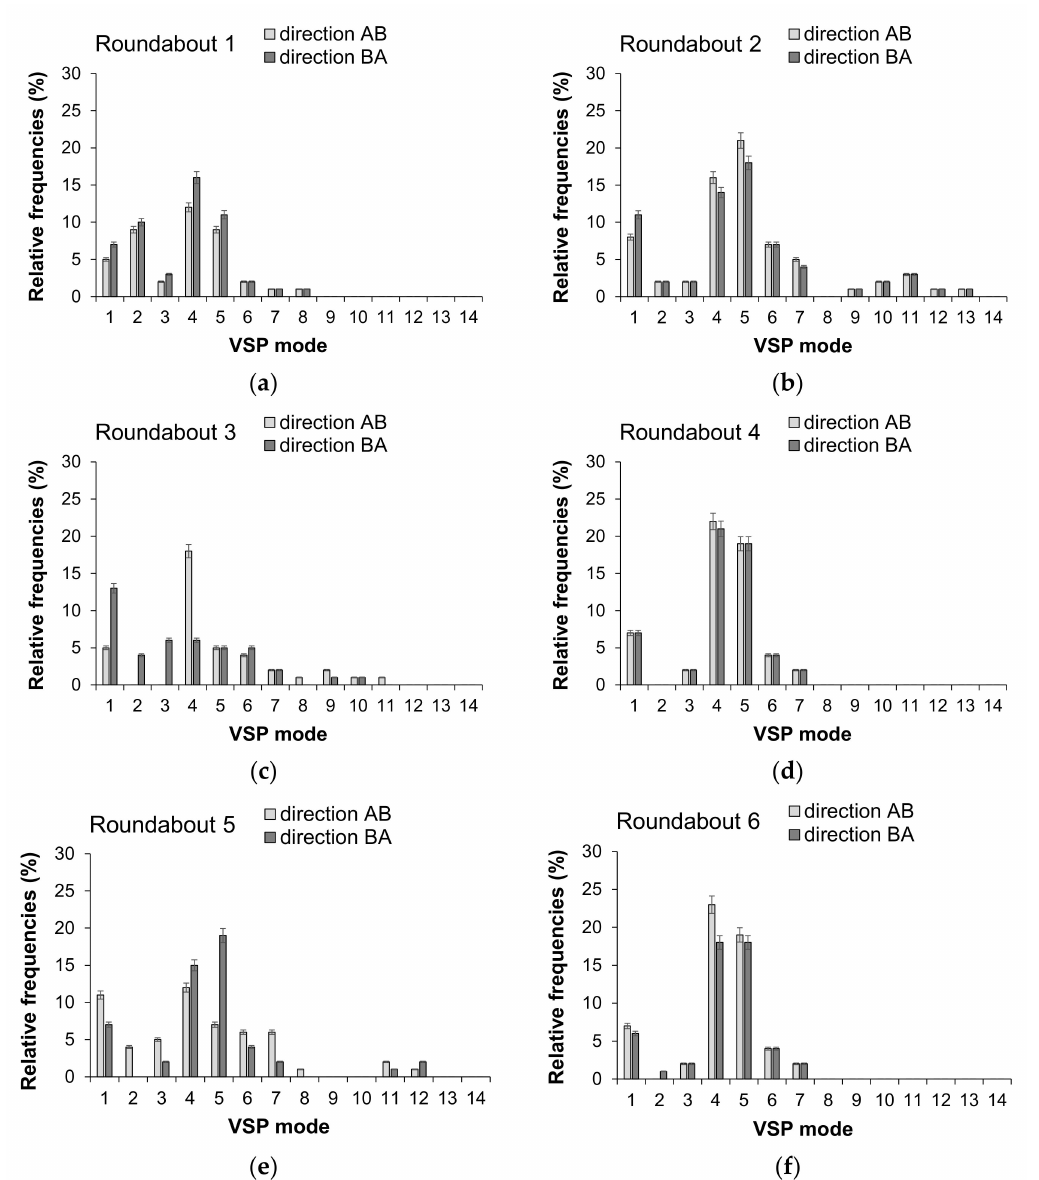
Figure 4. Relative frequencies of time spent in VSP modes at the sampled roundabouts in Figure 2 as follows: ( a ) Roundabout 1; ( b ) Roundabout 2; ( c ) Roundabout 3; ( d ) Roundabout 4; ( e ) Roundabout 5; ( f ) Roundabout 6. Note: direction AB means the through movement from A to B in Figure 2; direction BA means the through movement from B to A in Figure